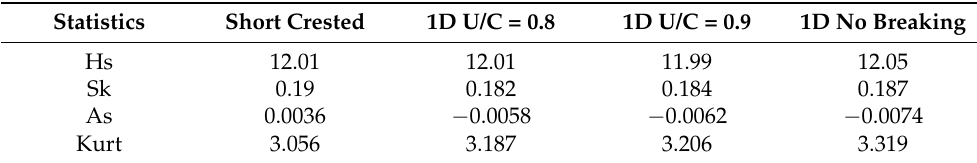
Table 3. Statistical values averaged from all buoys data in 1D and 2D simulations.